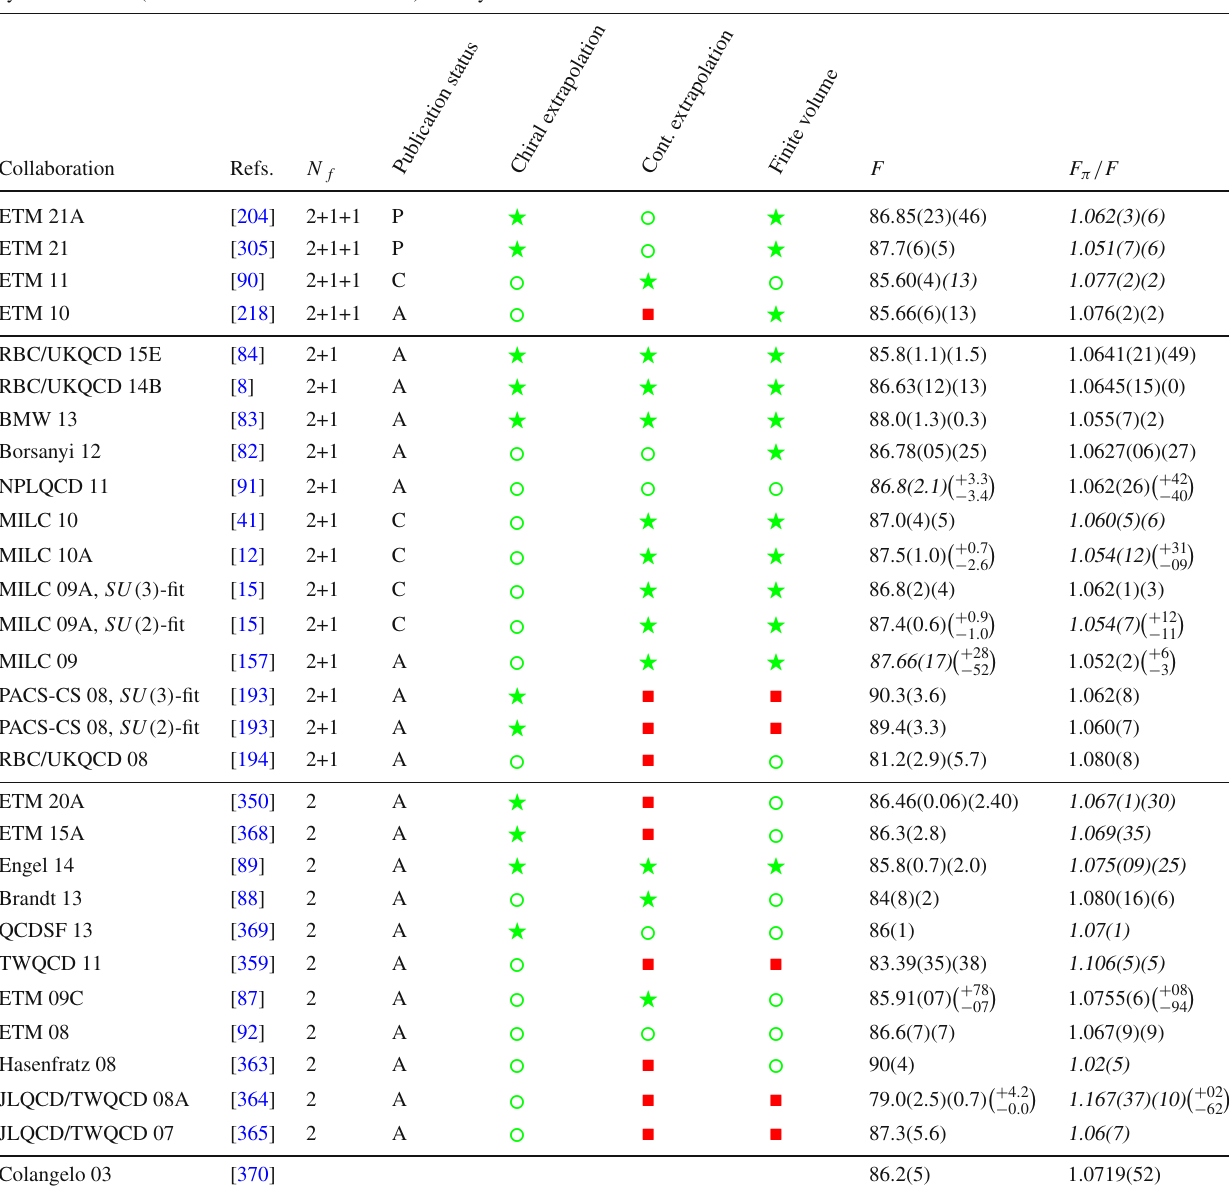
Table 22 Results for the SU ( 2 ) low-energy constant F (in MeV) and for the ratio F π / F . All ETM values that were available only in r 0 units were √ slanted fonts have been calculated by us, based on 2 F phys π = 130 . 41 ( 20 ) MeV [201], with this error being added in quadrature to any existing systematic error (otherwise to the statistical error). The systematic error in ETM 11 has been carried over from ETM 10